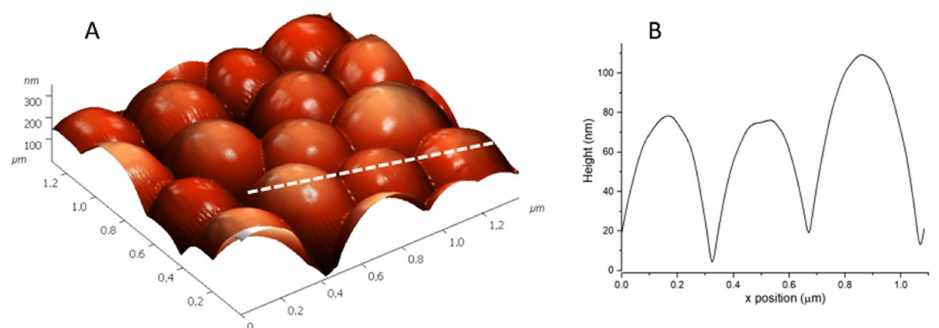
Figure 4. 3D-AFM image of TEOS / O 8 TES hybrid film deposited on clean glass slide ( A ) and cross-section corresponding to the dotted line ( B ).